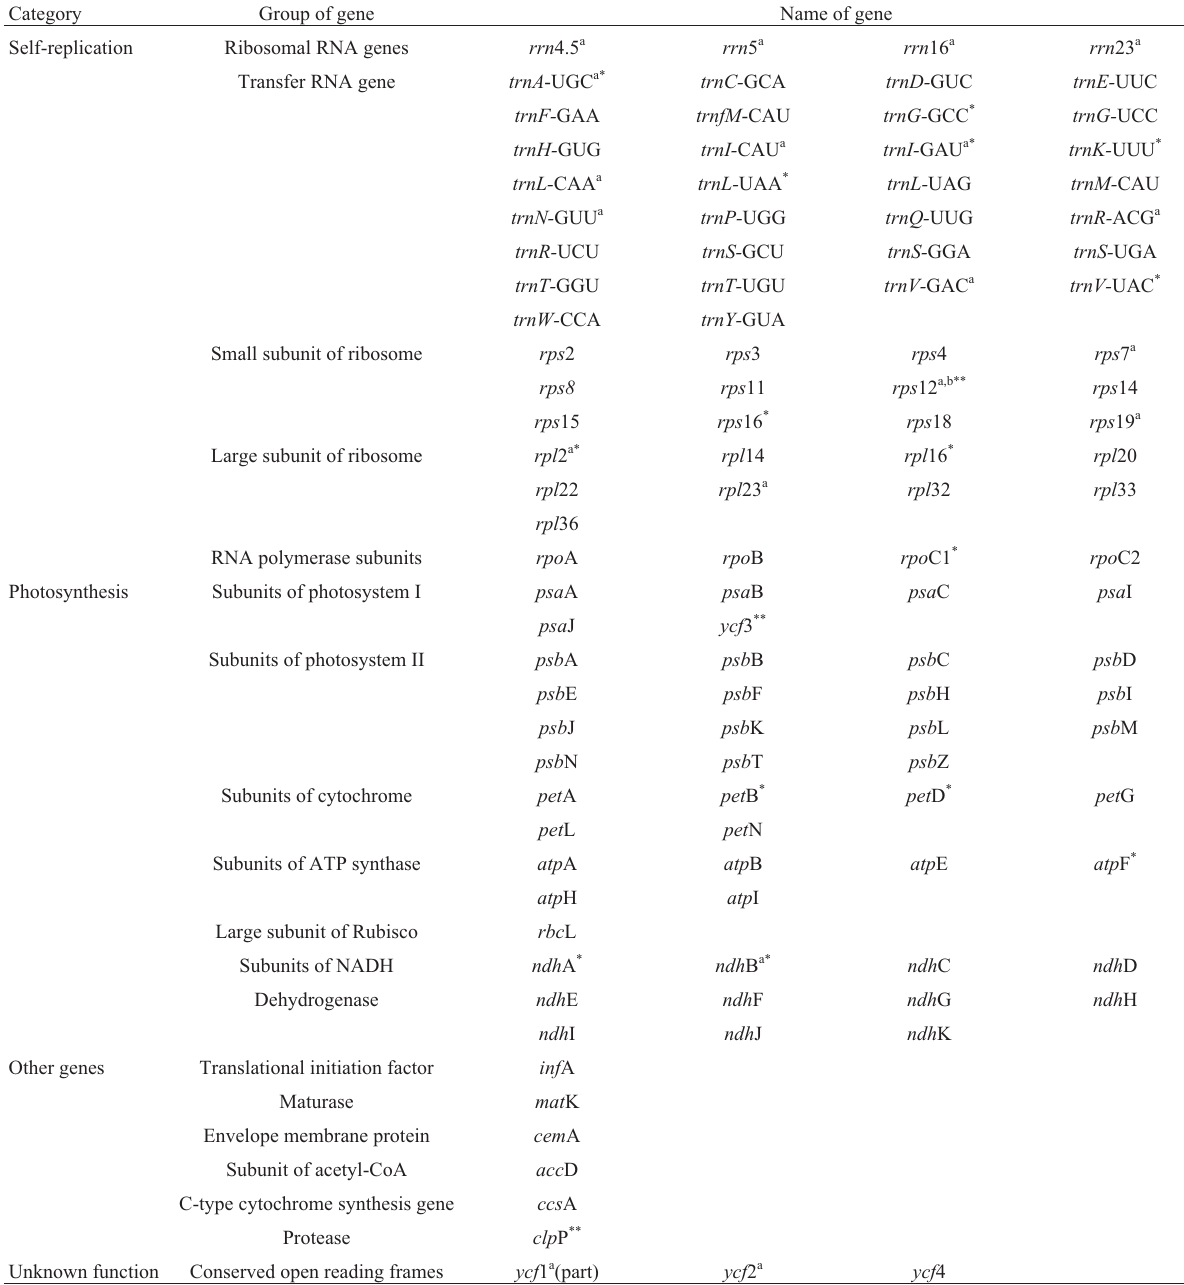
Table 1 - Genes contained in P. setigerum chloroplast genome (113 genes in